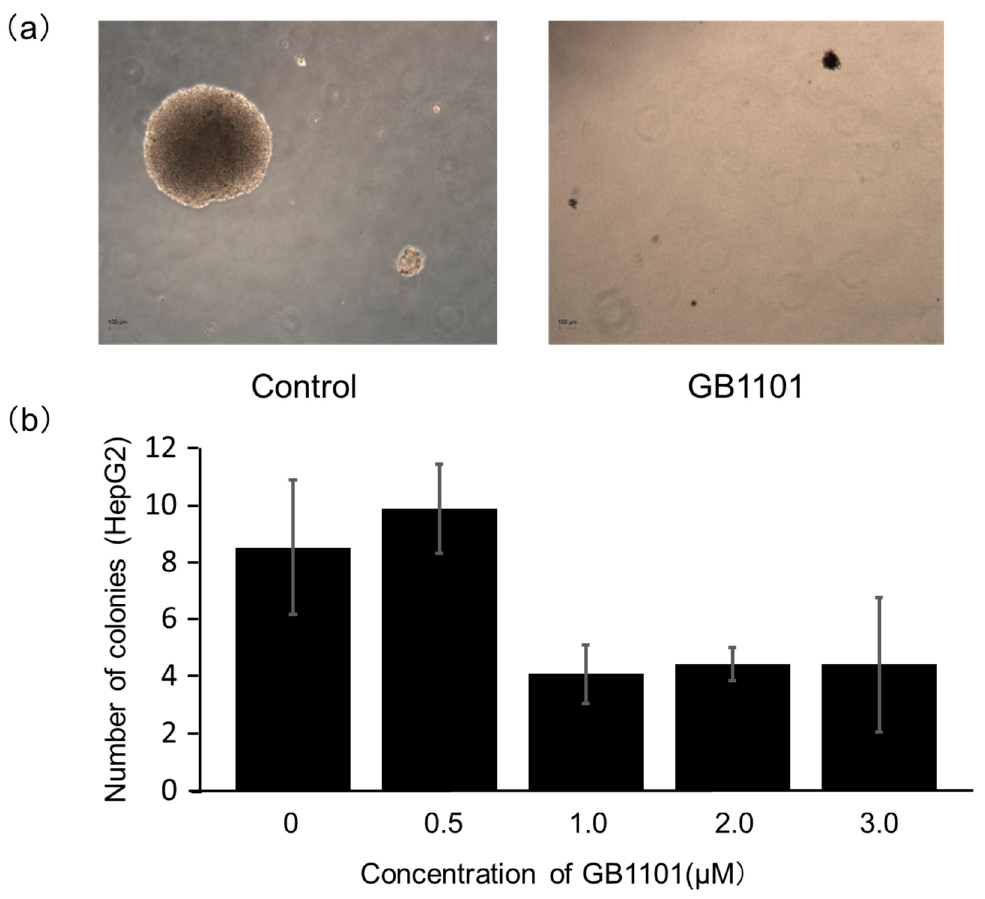
Figure 2. Colony formation of HepG2 cells treated with GB1101. ( a ) Human hepatoblastoma HepG2 cells were cultured in soft agarose in the absence or presence of 0.5 to 3 µ M GB1101. ( b ) Colonies were counted 14 days after treatment. Data are presented as the mean ± SD (n = 3).